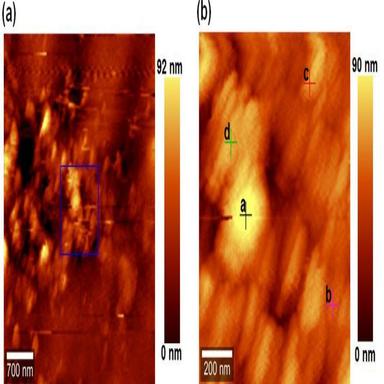
(a) AFM contact mode image of the GAC sample, and (b) a corresponding higher-resolution AFM image obtained from an area shown in (a) with a square box.